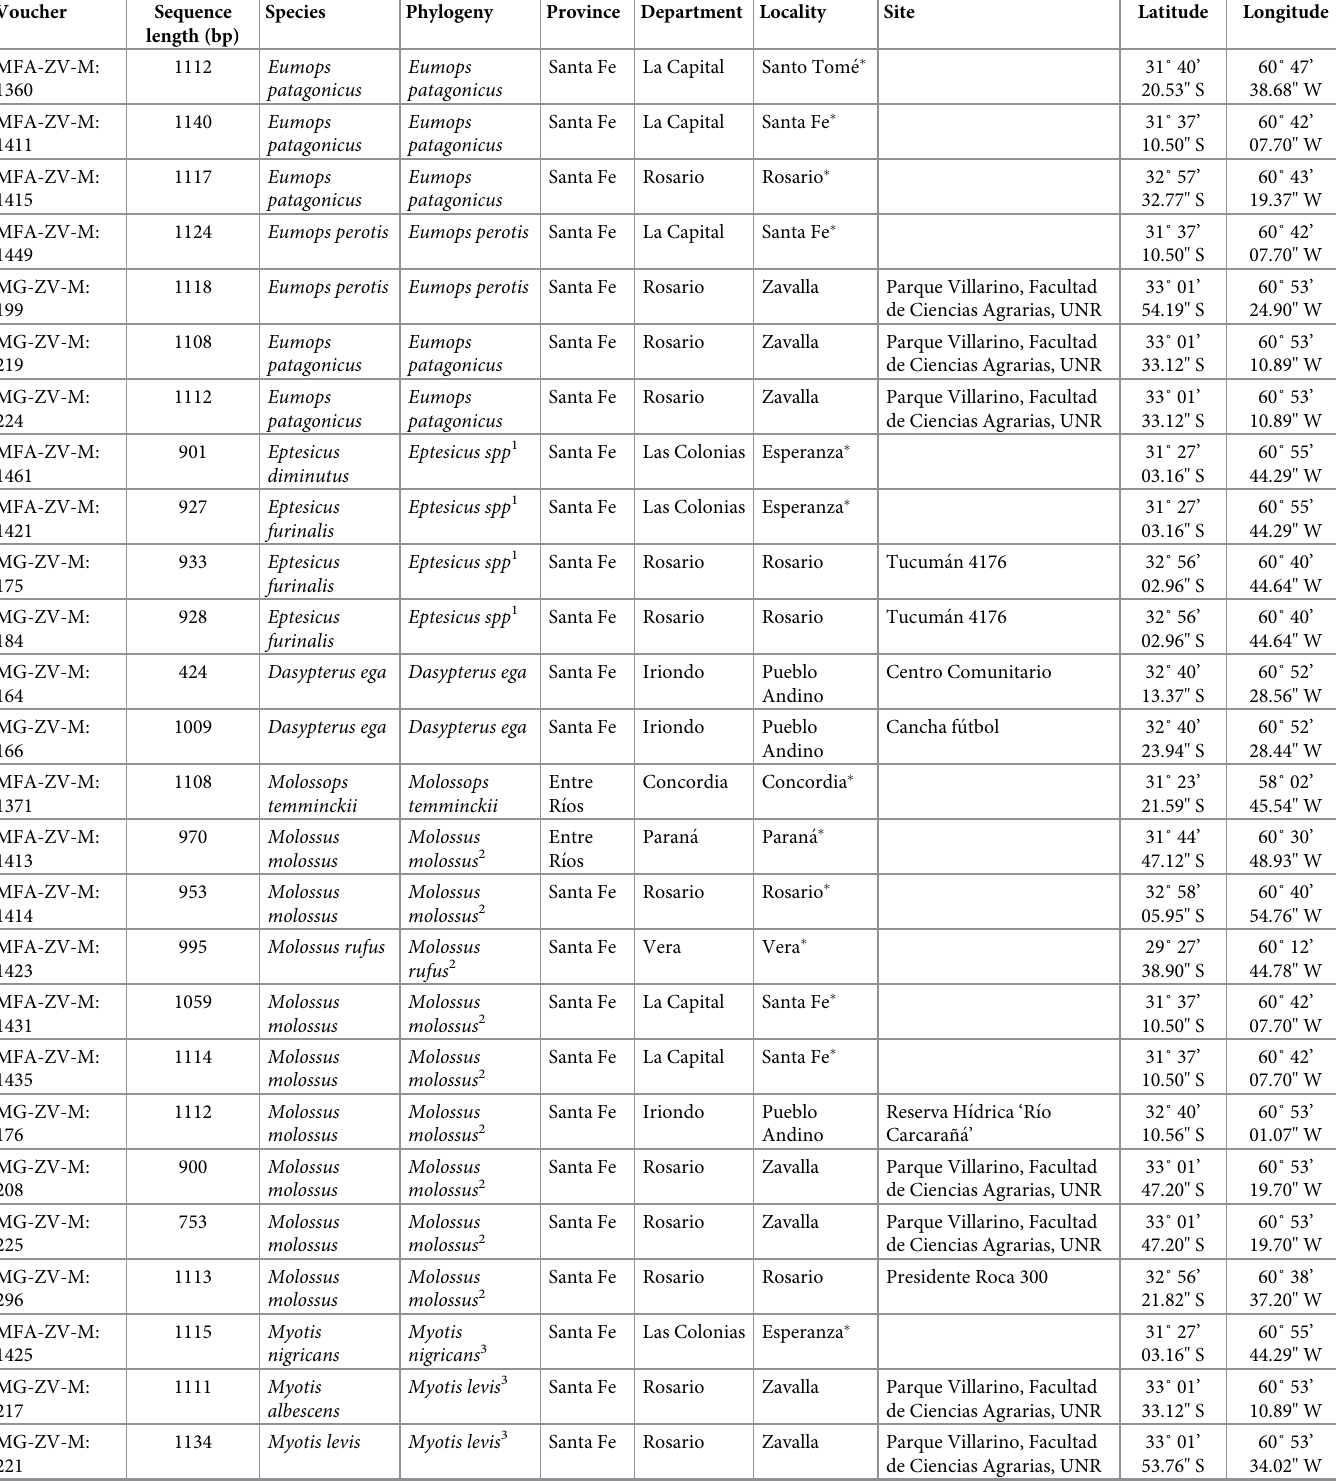
Table 2. Molecular and morphological identification of voucher